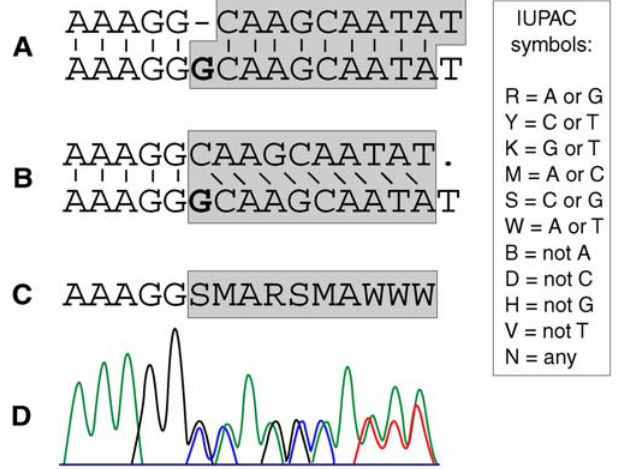
Figure 1. A pair of allelic sequences properly aligned (A), unaligned (B), and translated into a consensus (C). The trace resulted from direct sequencing of the pair is shown in (D). The one- base insertion is shown in bold face. Links between the allelic strings represent positional homologies. The bases forming mixed trace are highlighted with grey. The standard IUPAC symbols for 2-fold degenerate DNA bases are enclosed in the box.